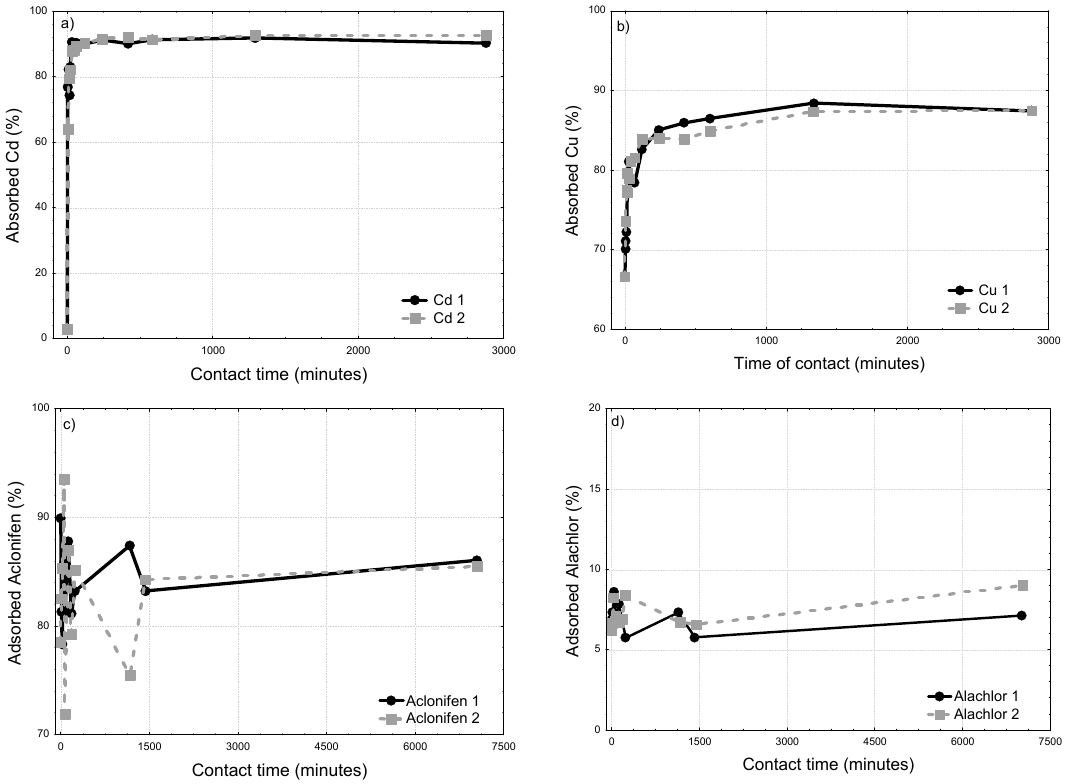
Figure 3. Sorption kinetics of Cd ( a ), Cu ( b ), Aclonifen ( c ) and Alachlor ( d ) onto river suspended particulate matter. 1 and 2 are duplicates. SPM Load is 1 g L − 1 .